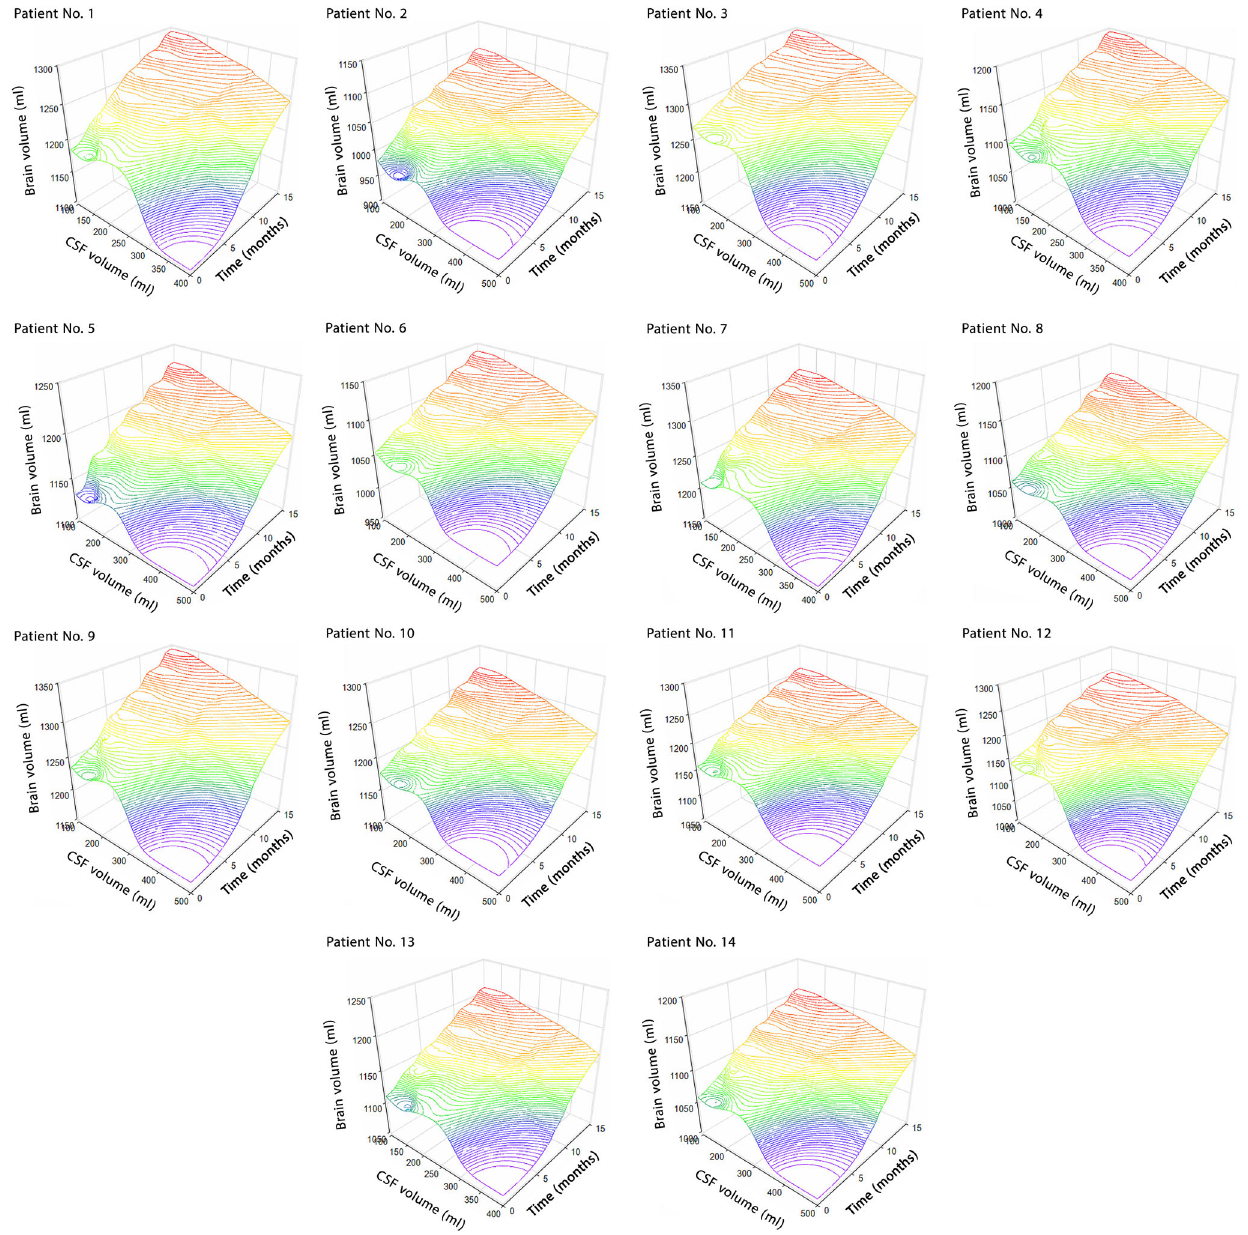
Fig. 5 Changes in ICP, CSF volume, and time concurrently. The changes in CSF volume and brain volume with respect to time (months after shunting). The plans show the concurrent changes in volumes after shunting. Raw data for Fig. 5 is included in Supplementary Table. CSF cerebrospinal fl